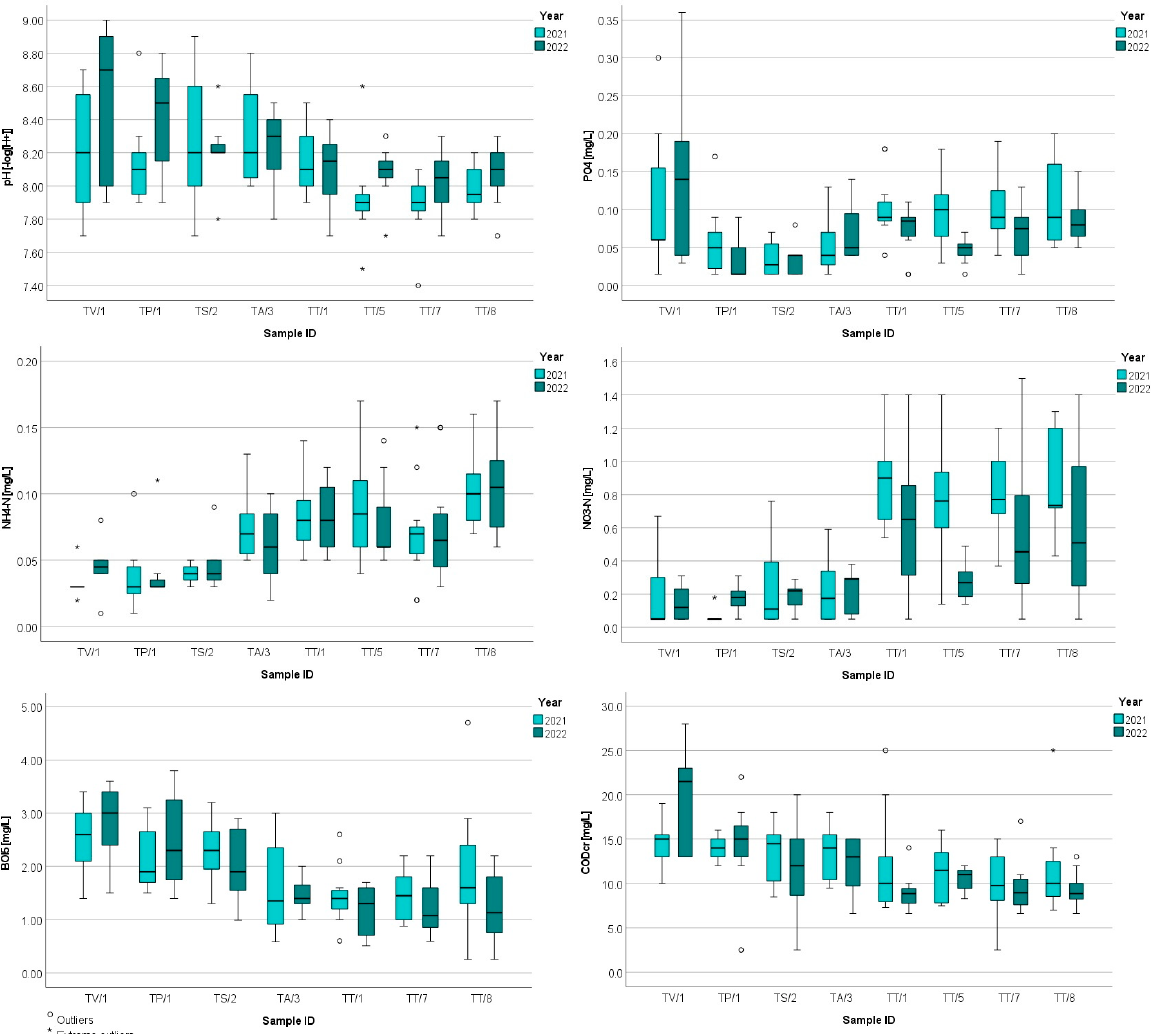
Figure 4. Box plots of pH, PO 4 -P, NH 4 -N, NO 3 -N, COD cr and BOI 5 , for the sampling years (2021, 2022).